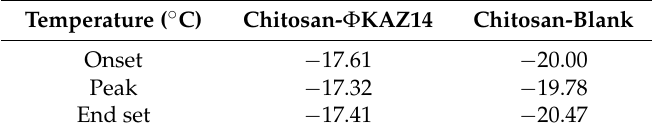
Table 2. Differential scanning calorimetry (DSC) of bacteriophage-based chitosan nanoformulation. Temperature ( ˝ C) Chitosan- Φ KAZ14 Chitosan-Blank Onset ´ 17.61 ´ 20.00 Peak ´ 17.32 ´ 19.78 End set ´ 17.41